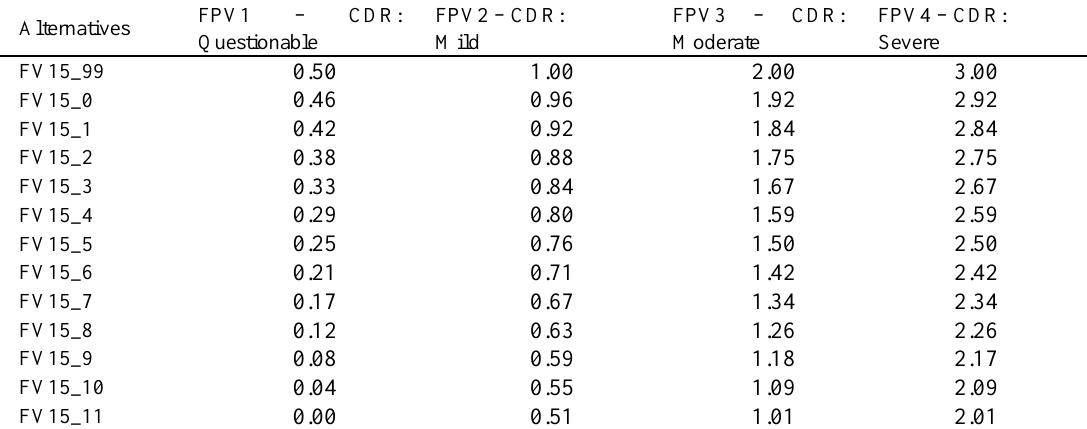
Table 2. Values of each level of impact for each FPV in relation to